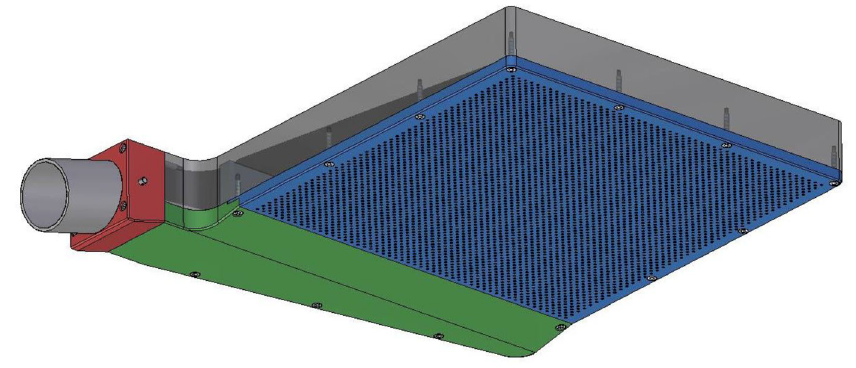
Fig. 3 The canopy air curtain underneath the roof of the shuttle car (drawing by Marshall University and J.H. Fletcher,